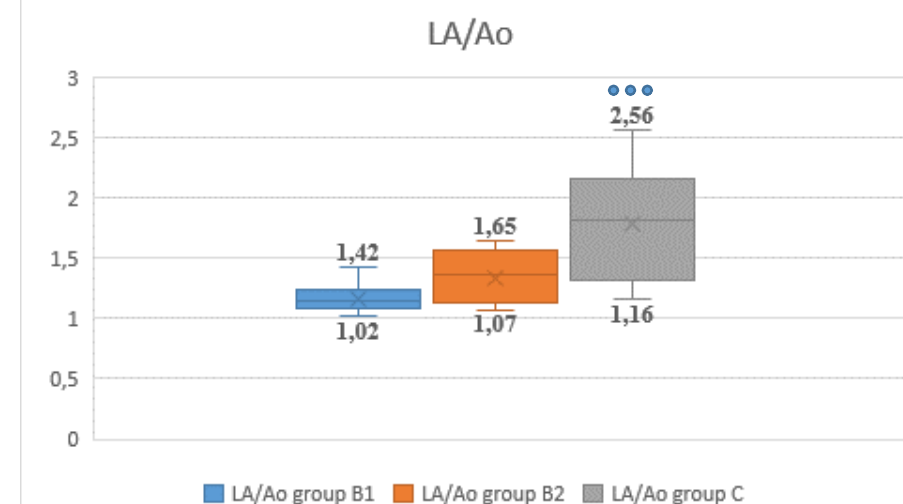
Fig. 5. Box and whisker plot of the LA/Ao ratio in early diastole with the development of MMVD, indicating the limits of each experimental group.